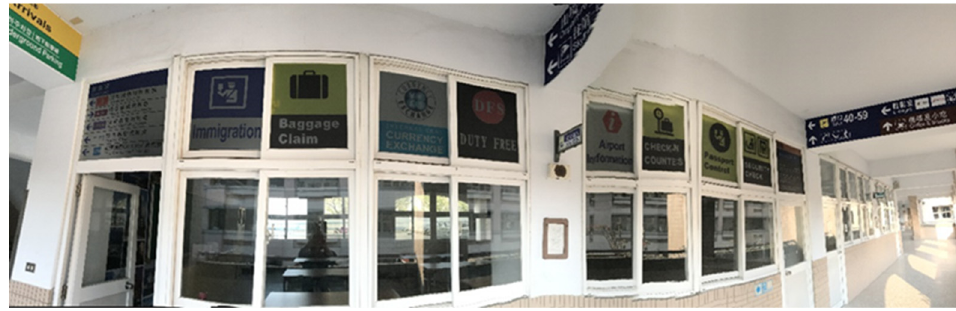
Figure 3. Situational context class for English teaching.